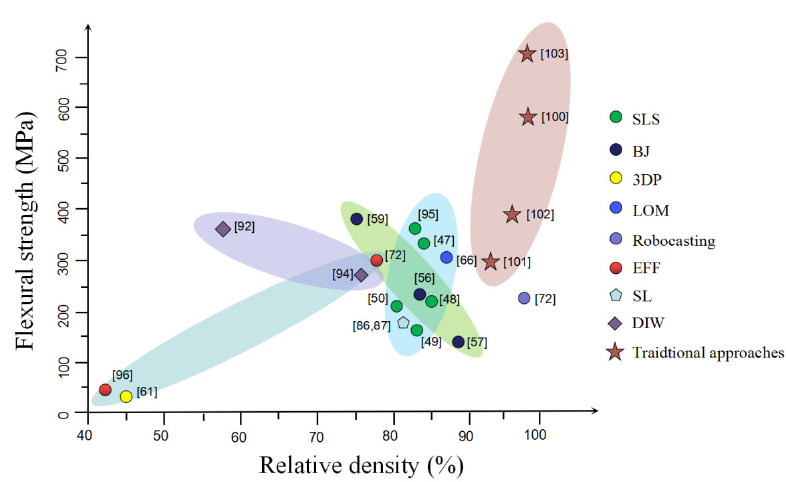
Fig. 35 Comparison of the relative density, mechanical properties of SiC ceramic by different additive manufacturing